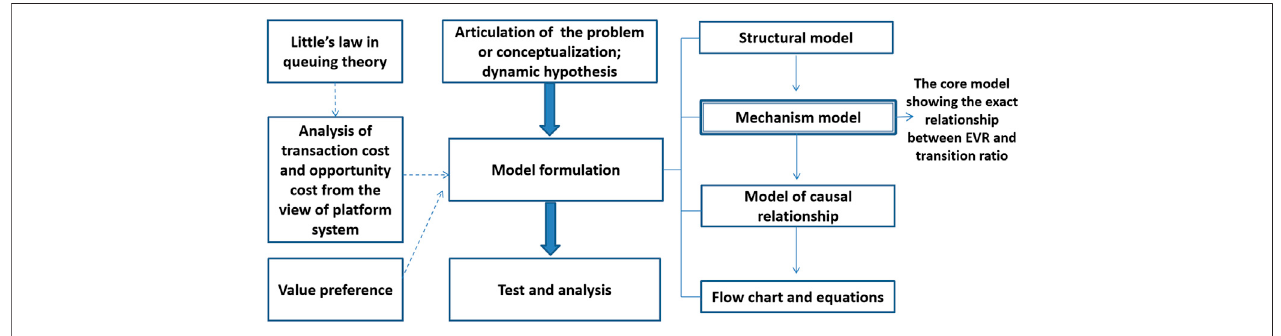
FIGURE 1 | Research